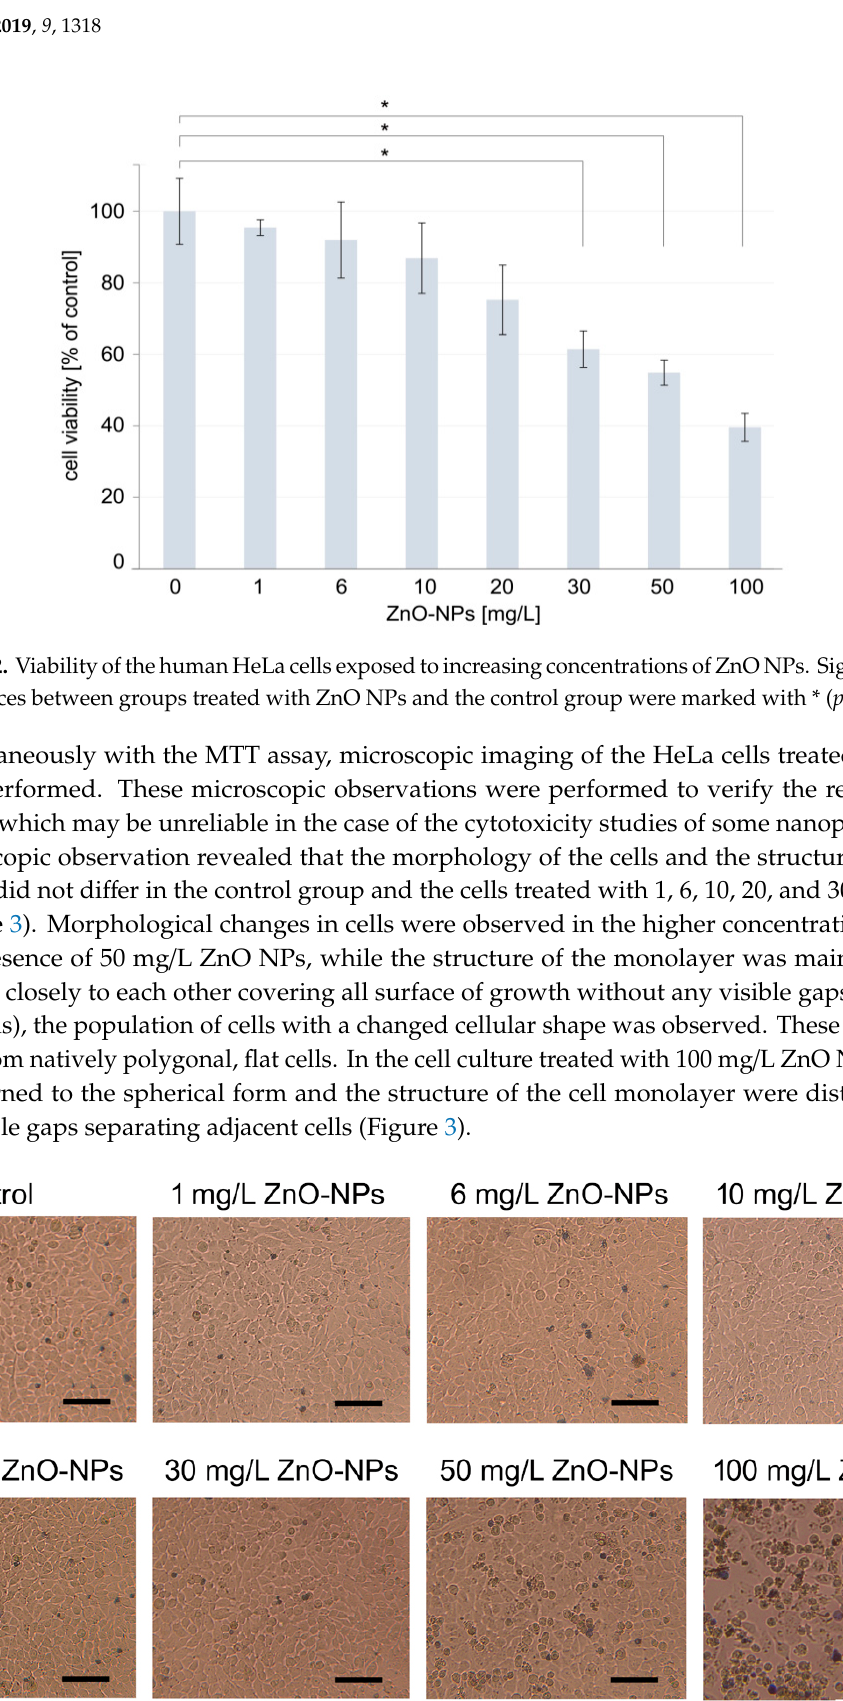
Figure 3. Optical microscopy images of HeLa cells treated with increasing concentration of ZnO NPs. Scale bars represent 100 µm.